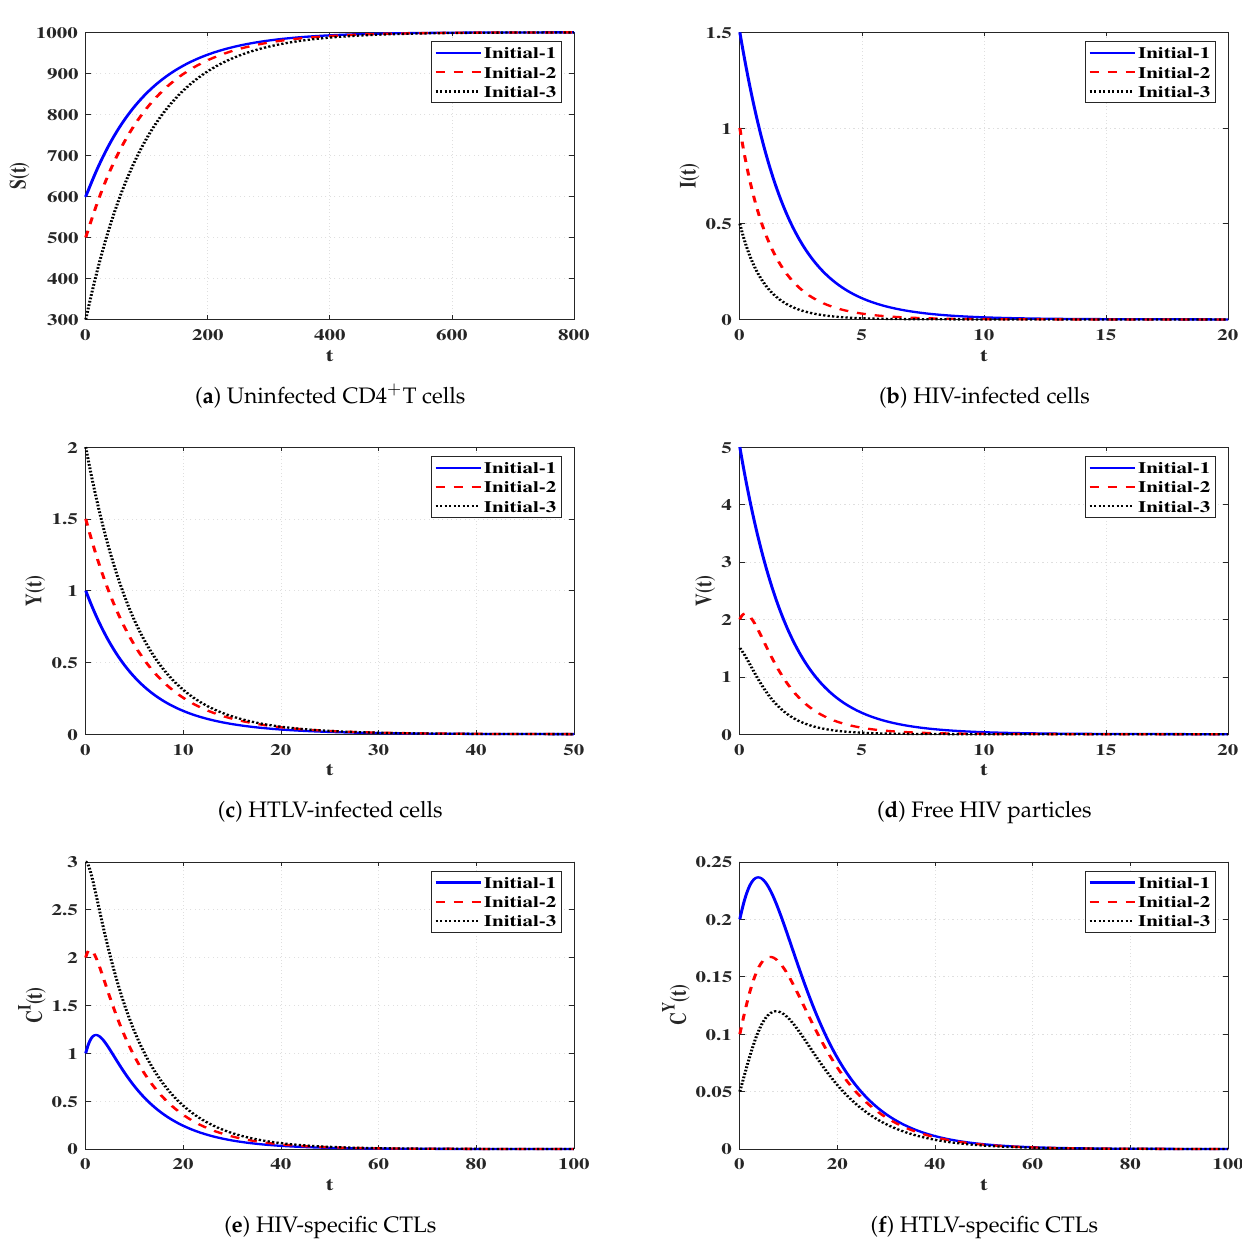
Figure 2. Solutions of system (4) when (cid:60) 1 ≤ 1 and (cid:60) 2 ≤ 1. Set 4 (Stability of Ð 3 ) : η 1 = 0.001, η 2 = 0.003 and σ 1 = σ 2 = 0.01. Then, we calculate (cid:60) = 1.43 > 1 and (cid:60) = 0.86 < 1. From Table 1 and Figure 5, we conclude that the 3 5 trajectories starting with different states tend to Ð 3 = ( 285.83, 10, 0, 24.97, 1.07, 0 ) . Therefore, Ð 3 is G.A.S, and this is compatible with Theorem 4. This leads to the case of persistent HIV single infection with an effective HIV-specific CTL immune